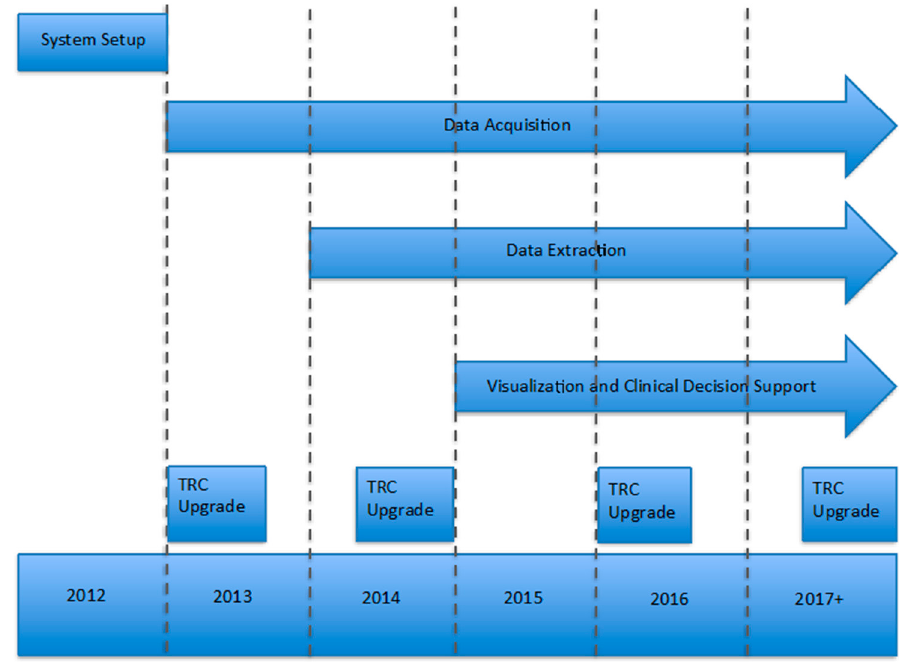
Figure 2. Mayo Clinic genomic data warehouse implementation timeline. TRC: Translational Research Center.